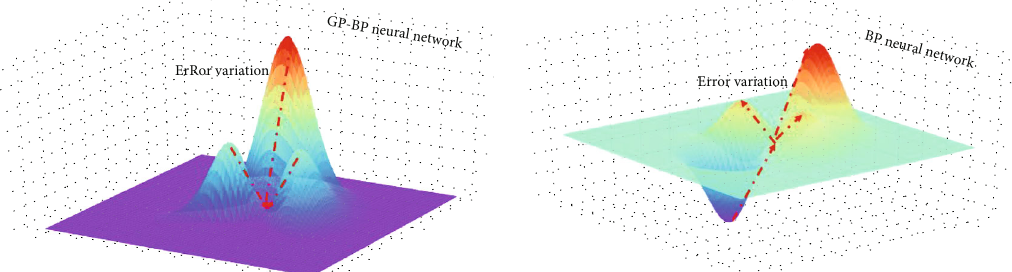
Figure 10: Variation law of error loss of di ff erent